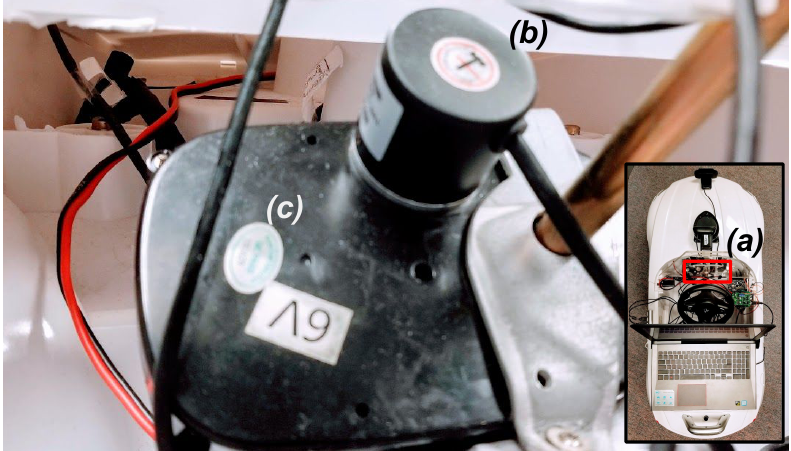
Figure 10. The encoder attachment for the driving motor. The picture is the region ( a ) from the inset picture. ( b ) is the encoder, and ( c ) is the gearbox in which the encoder is